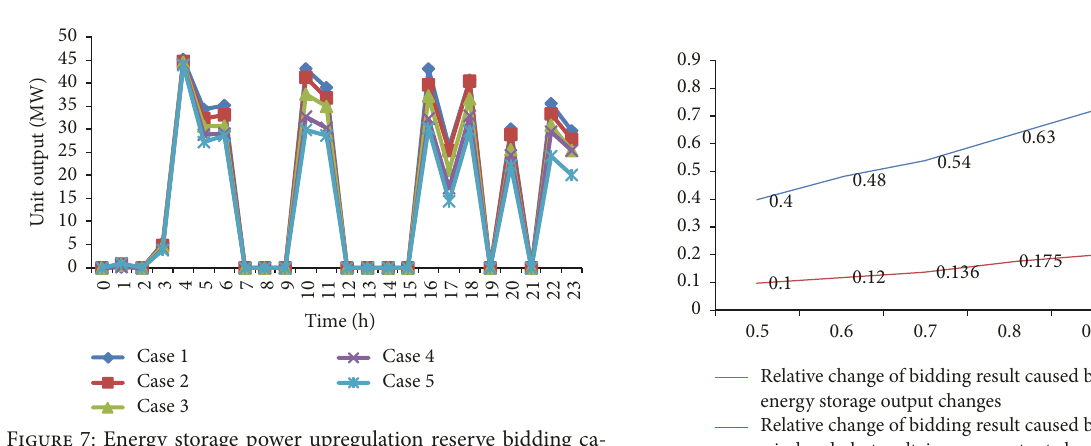
Figure 9: Energy storage power spinning reserve bidding capacity.